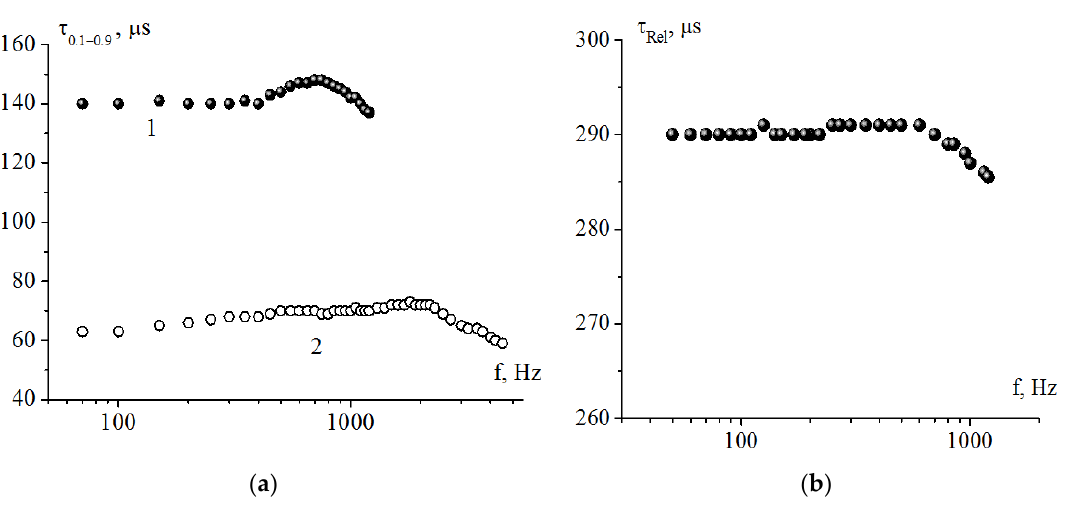
Figure 5. Frequency dependences ( a ) of the optical response time at ±1.5 V (curve 1) and ±12 V (curve 2) pulses acting and ( b ) of the director relaxation time after ±1.5 V pulses turning off. The FLC composition is HF32E ( γ φ = 1.5 P). A bipolar voltage of rectangular shape (meander) was applied. The thickness of the electro- optical cell is 1.7 μm.